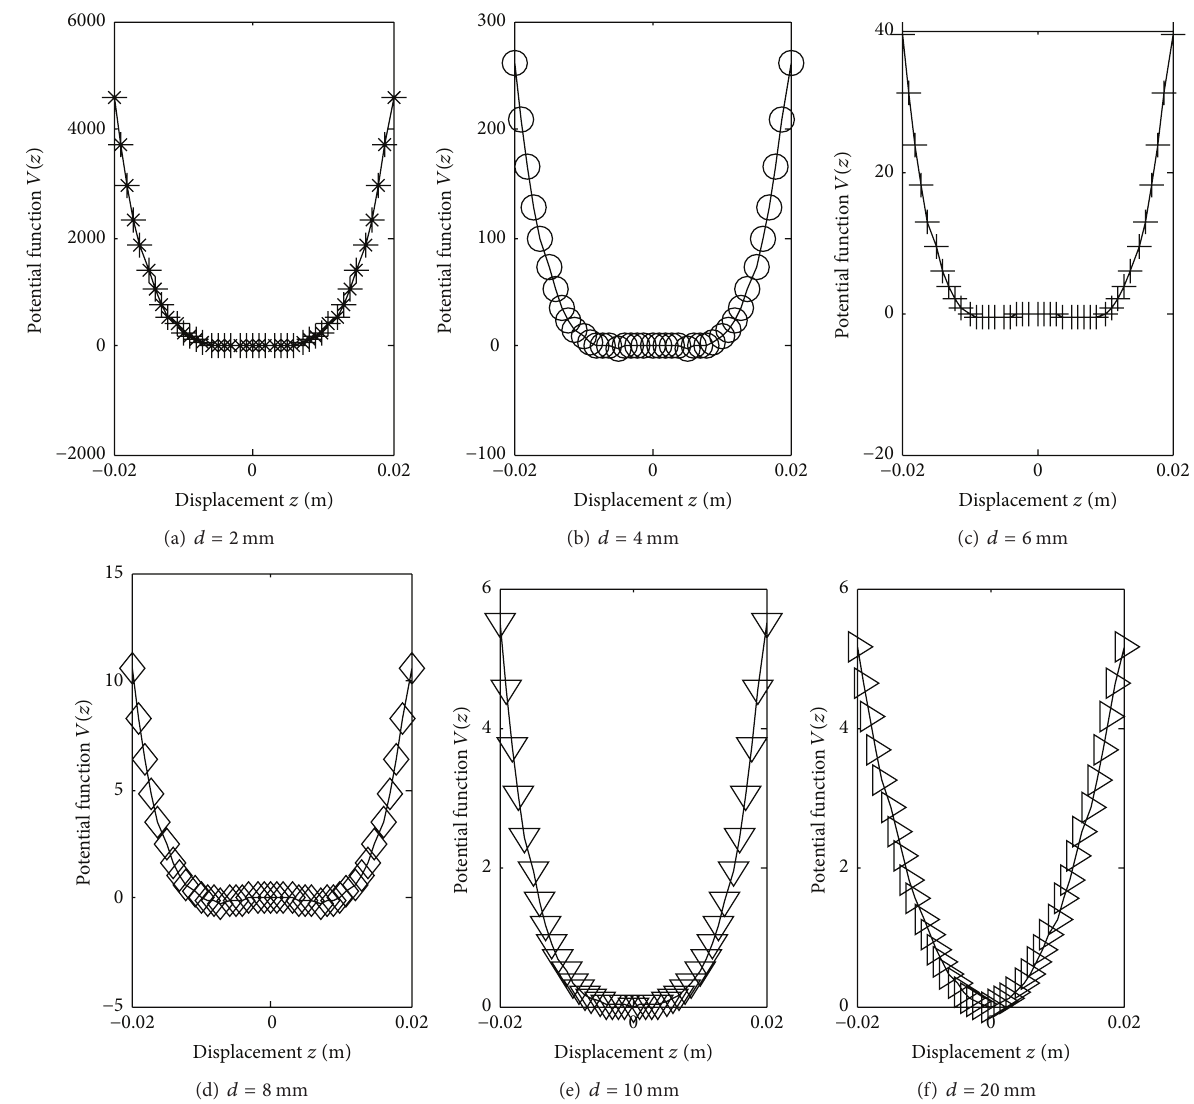
Figure 3: Potential functions of the unperturbed nonlinear PVEH system under different distances.